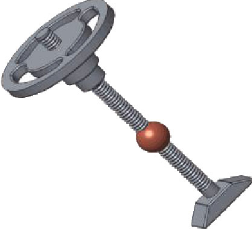
Figure 2: The top plate of the prosthesis.